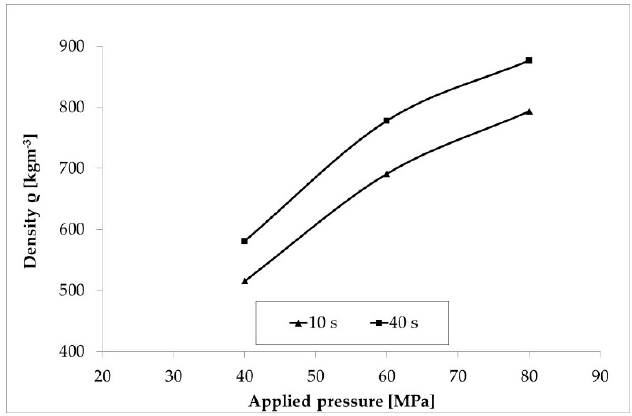
Figure 3. Relationship between hop cones compacts density (kg m − 3 ) and compression pressure (MPa) at different pressure application times (10 and 40 s).